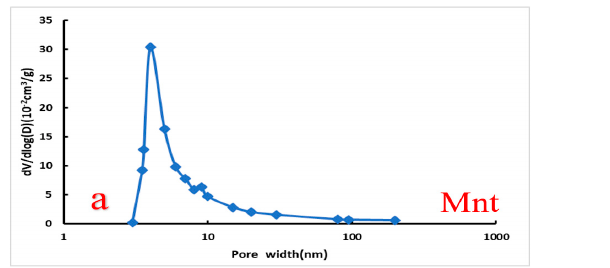
Figure 8. Pore size distribution curve of montmorillonite samples (( a ) obtained by BJH method, ( b ) obtained by NLDFT method) [18]. Reproduced with permission from Xiong J., Doctoral thesis of Southwest Petroleum University; published by Southwest Petroleum University, 2015.